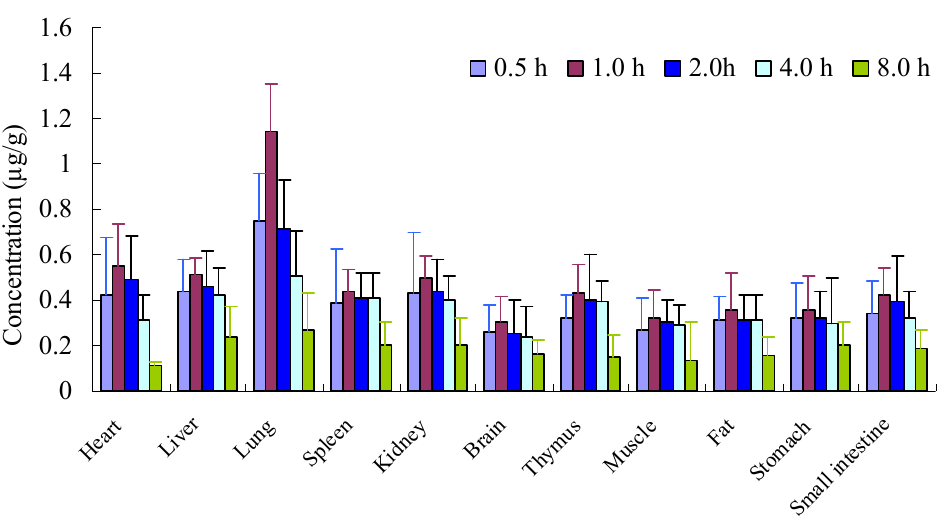
Table 4. The main pharmacokinetic parameters of PD after i.v. administration ( n = 6) t distribution phase half-life; t concentration-time curve from zero up to infinite time; CLs: systemic clearance. Parameter